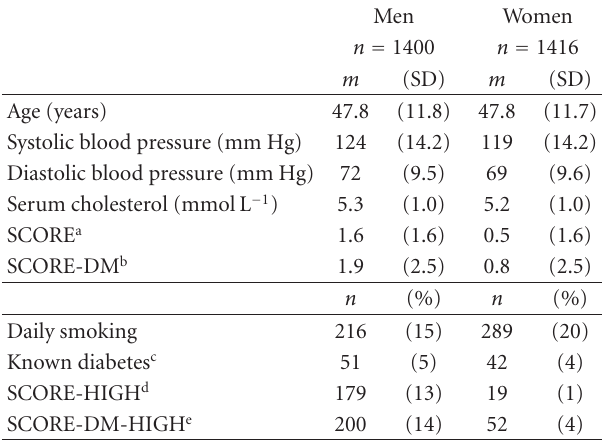
a SCORE: risk score according to the original model, with missing values for 6 men and 4 women. b SCORE-DM: risk score considering diabetes, with missing values for 7 men